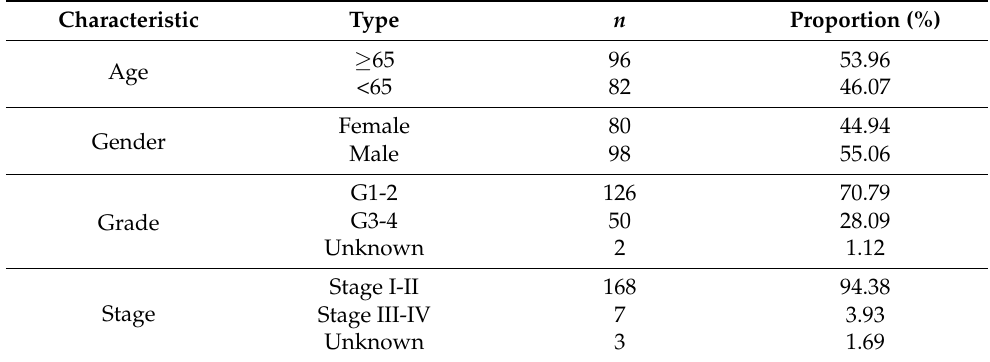
Table 1. Clinical pathological parameters of 178 patients with PAAD from TCGA